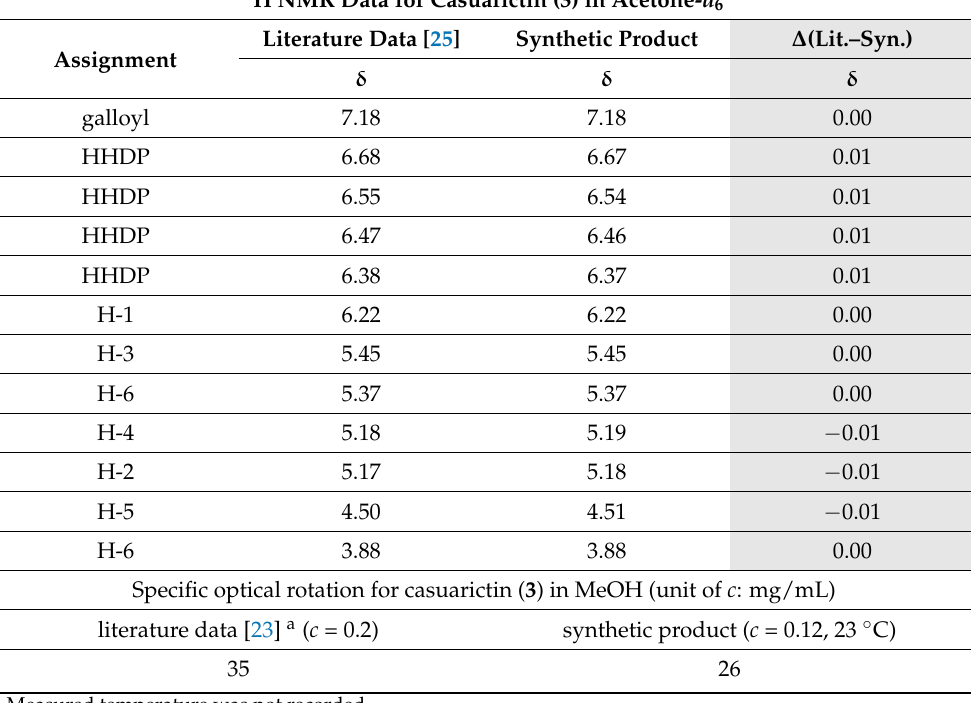
Table A3. Comparison of the spectral data between the synthetic casuarictin ( 2 )and the literature data of 2 [25].